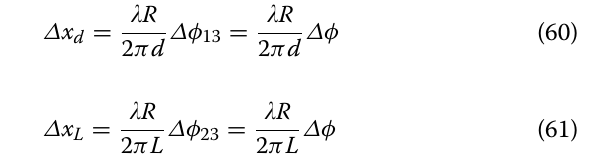
Assuming the noise background of each array element in the USBL system is independent, the phase differences φ ij and ψ ij have the same measurement accuracy Δφ , which meets the equation Δφ 13 Δφ 23 Δφ . = =